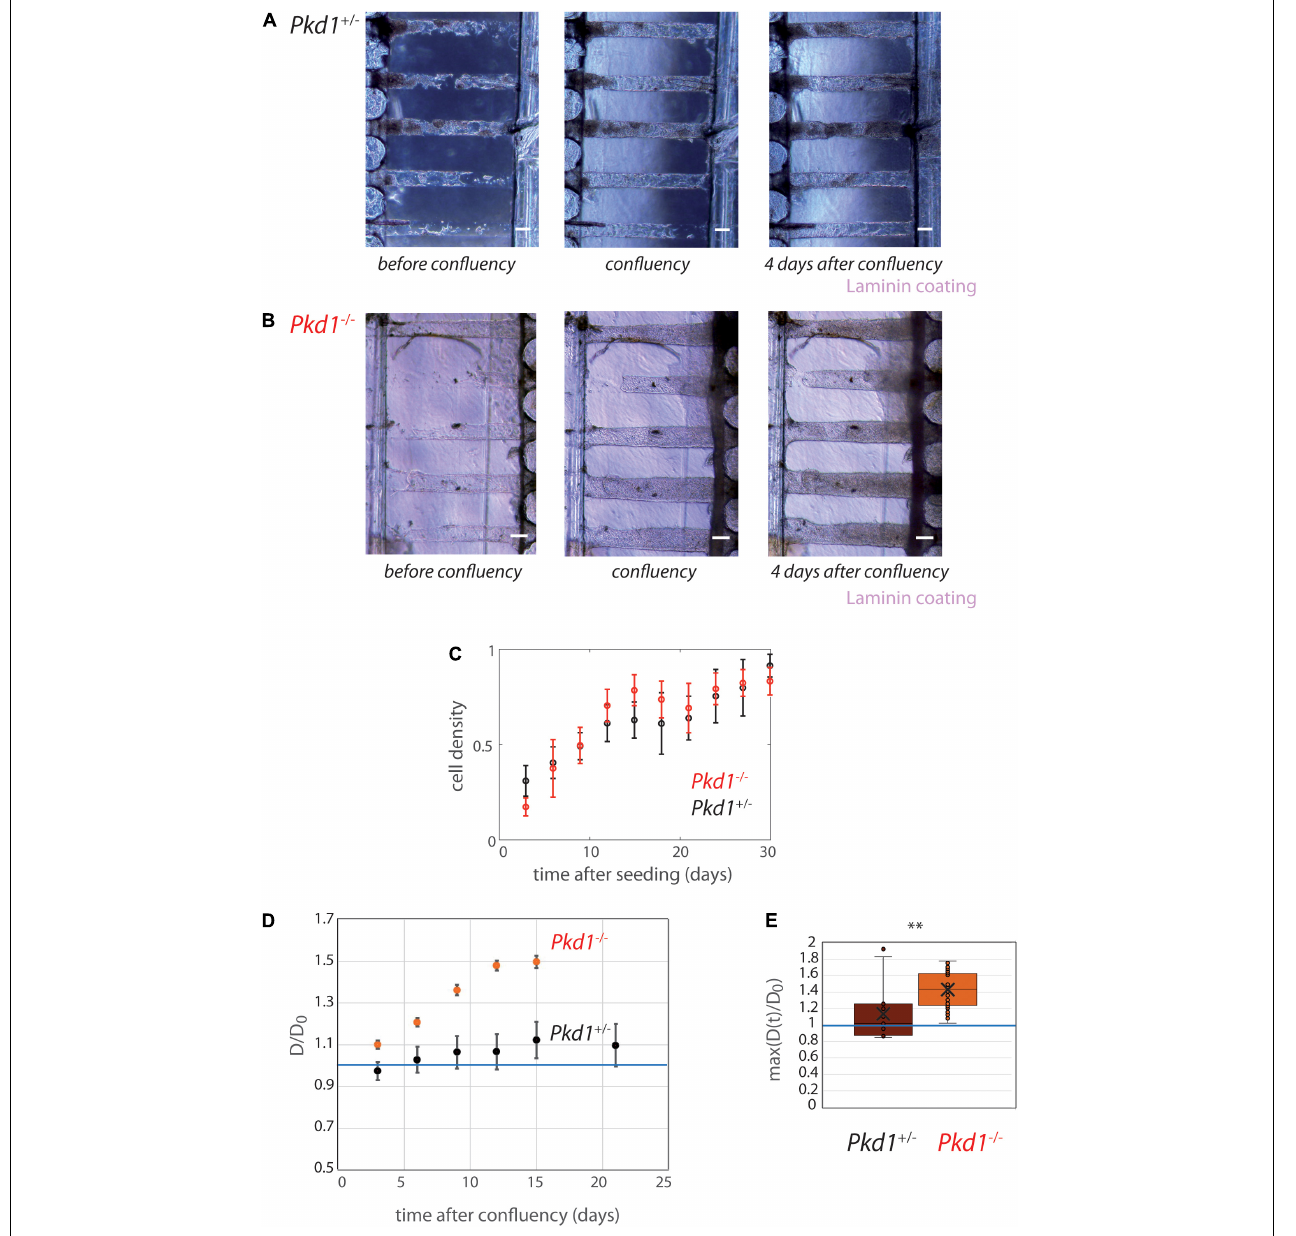
FIGURE 5 | PCT Pkd1 +/- and Pkd1 -/- tube deformation in chips with 200 µ m spacing. (A,B) Examples of temporal evolution of tubes with laminin coating, for Pkd1 +/- cells (A) and Pkd1 -/- cells (B) . Scale bar:100 µ m. Days after seeding: (A) 11, 16 (confluency), 20, (B) 9, 10 (confluency), 14. (C–E) Quantitative analysis, n = 12 Pkd1 +/- chips (black) and n = 14 Pkd1 -/- chips (red), all coatings pooled (see Supplementary Figure 8 for separated behavior). (C) Mean cell density over time. Error bars: S.E.M. (D) Kinetic evolution of mean tubes diameter normalized by diameters at seeding, in function of the time after tube confluency. A blue horizontal line at D/D 0 = 1, corresponding to no change in diameter, is indicated. Each time point corresponds to 8–35 tubes for Pkd1 -/- , 9–20 tubes for Pkd1 +/- . Error bars: S.E.M. (E) Maximum (over time) of the mean normalized diameter. Points correspond to individual tube values. Central bar, median; cross, mean; box, values between Q1 and Q3 quartiles; error bars, extreme values [between Q1 - 1.5*(Q3 - Q1) and Q3 + 1.5*(Q3 - Q1)]. (D,E) were computed only for tubes having reached full confluency during the observation period. ∗∗ indicates statistically significant difference with p =